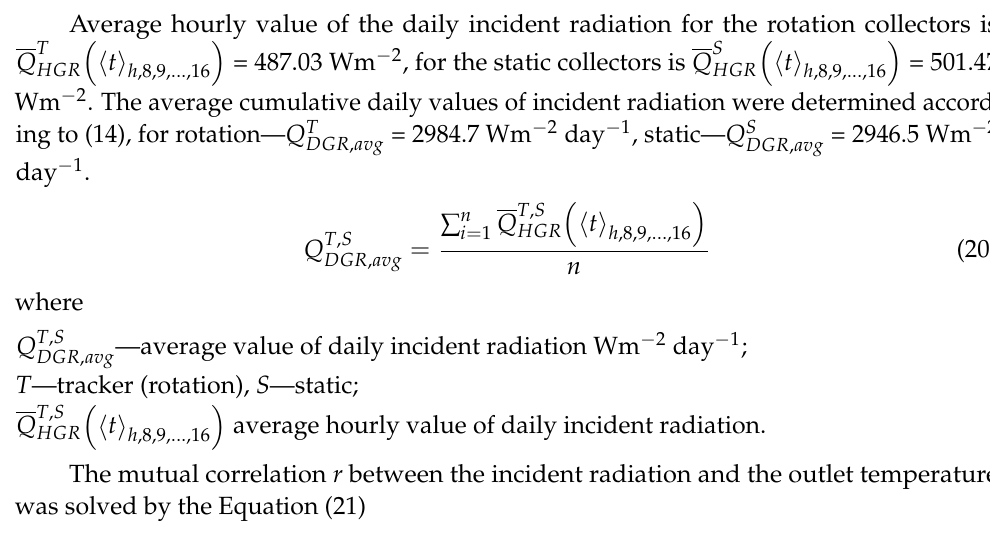
Figure 10. Cloudiness during the conducted experiment statement obtained from the Czech meteoro- logical company